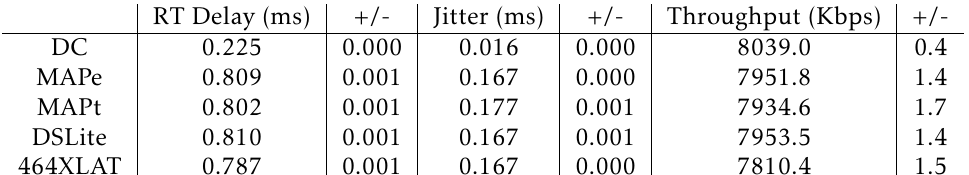
Table 3. 100 Mbps Results Averages